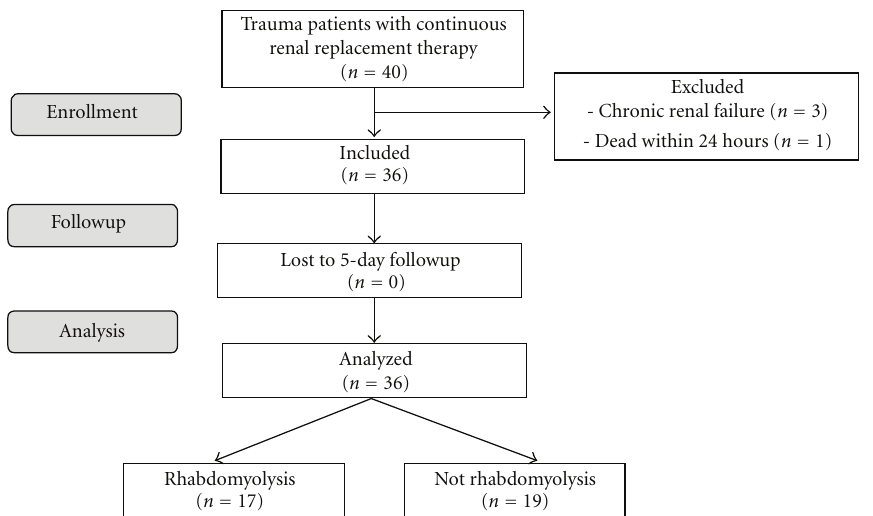
Figure 1: Flow chart of 36 adult trauma patients treated with continuous renal replacement therapy for acute kidney injury grouped with and without